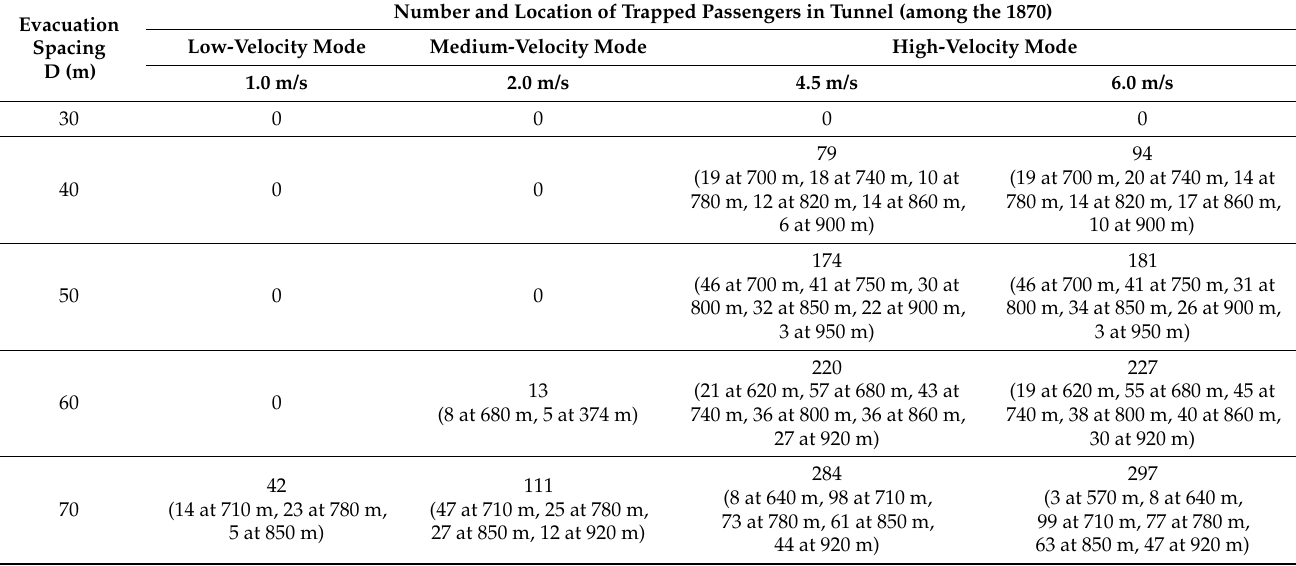
Table 10. Number and location of trapped passengers under different evacuation spacings.